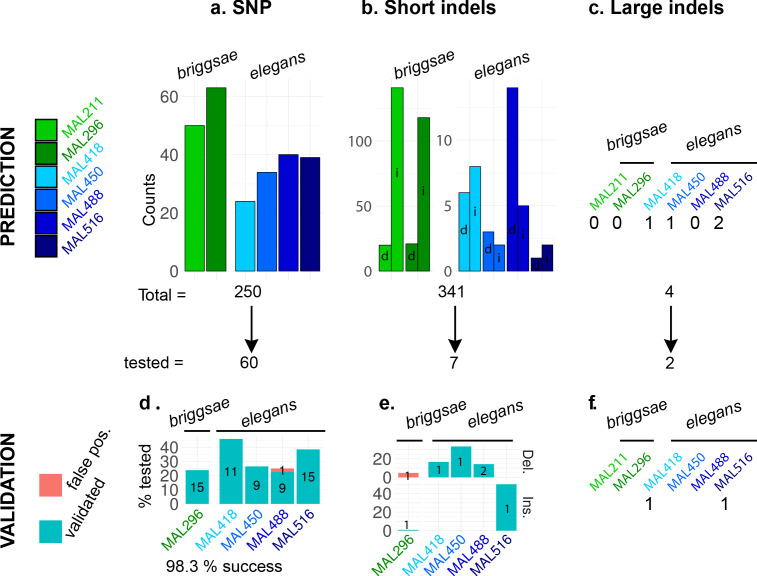
Variant discovery and validation in mutation accumulation lines.Raw counts of SNPs (a), short indels (b, bars with ‘d’ and ‘i’ are deletions and insertions, respectively) and large deletions (c) predicted by our variant discovery pipeline in each line of the panel. For each category, a subset was tested by direct re-sequencing (see Materials and methods), yielding a high rate of validation (d–f). 'Del.': deletions. 'Ins': insertions. 'pos.': positive. Note that for the SNPs, which show a good validation rate, the C. briggsae lines appear to have a higher rate of mutation, in accordance with their about twice higher rate of fitness decrease (Baer et al., 2005).